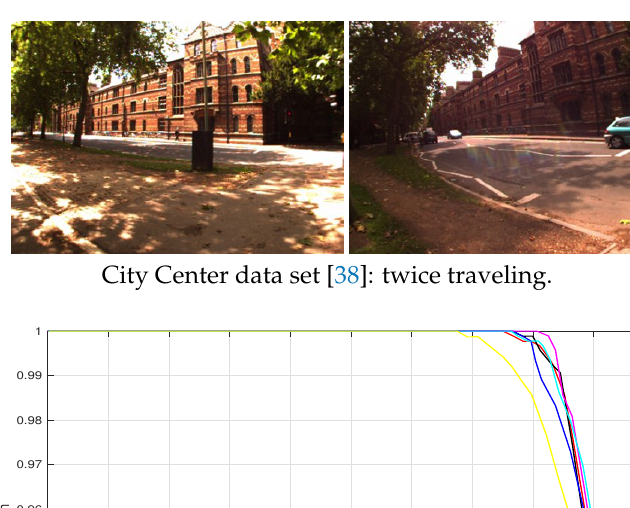
Figure 11. Precision-recall curves for the UTBM-1 data set (the trajectory acrosses forest, city, and parking areas) ( d s = 8).